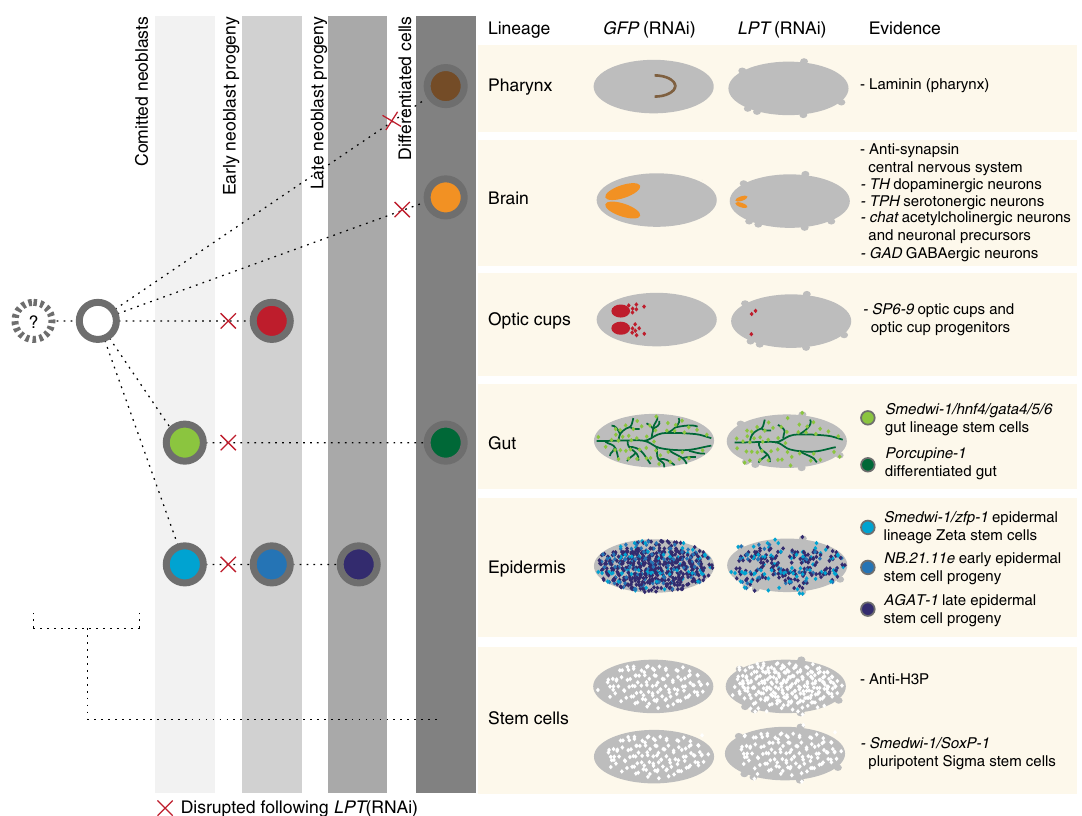
Fig. 6 LPT (RNAi) results in a cancer-like phenotype. A summary of the differentiation and neoblast proliferation data presented, together with a simpli fi ed fl owchart illustrating the tested lineages ’ development under knockdown conditions. A red cross sign indicates where the defect in a lineage is detected following LPT